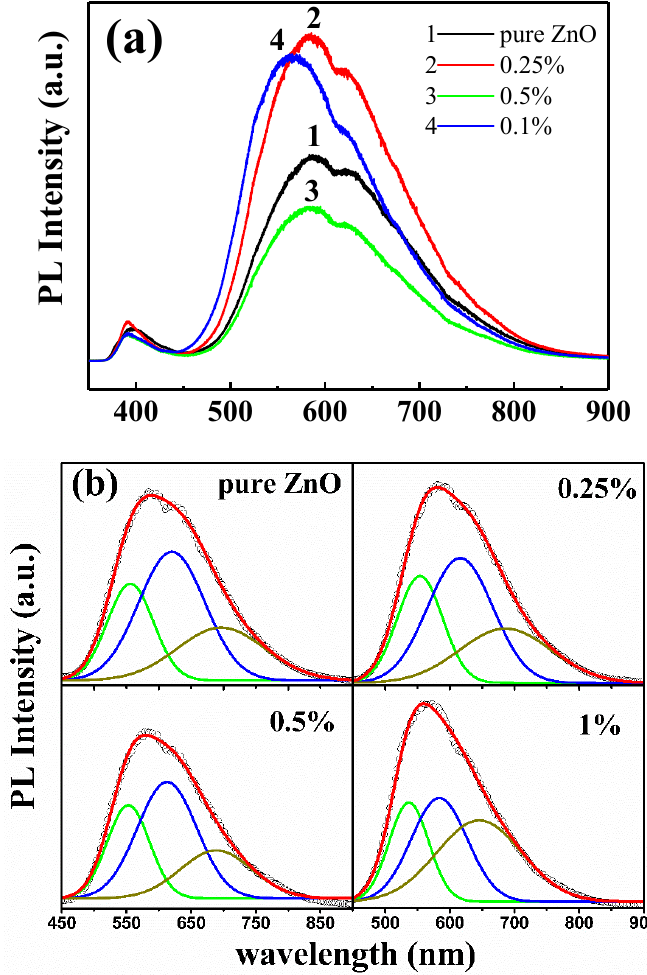
Figure 4. Room temperature (RT) photoluminescence spectra of undoped ZnO and lightly Cu-doped ZnO nanocrystals with different concentrations ( a ) and Gaussian fitted Curves ( b ) for these experimental spectra.